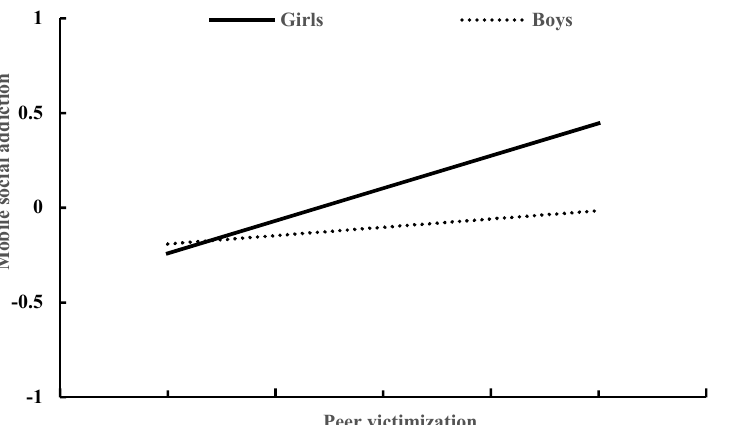
Figure 4. The relationship between peer victimization and mobile social addiction in girls and boys.